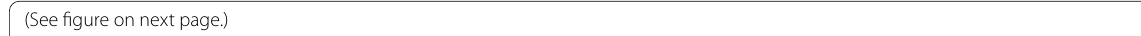
Fig. 2 The total displacement trend of 11 when U1-SN 105°. A The total displacement trend of 11 with the torque ridge height of 0 mm. B The = total displacement trend of 11 with the torque ridge height of 0.3 mm. C The total displacement trend of 11 with the torque ridge height of 0.5 mm. D The total displacement trend of 11 with the torque ridge height of 0.6 mm. E The total displacement trend of 11 with the torque ridge height of 0.7 mm. F The total displacement trend of 11 with the torque ridge height of 0.8 mm. G The total displacement trend of 11 with the torque ridge height of